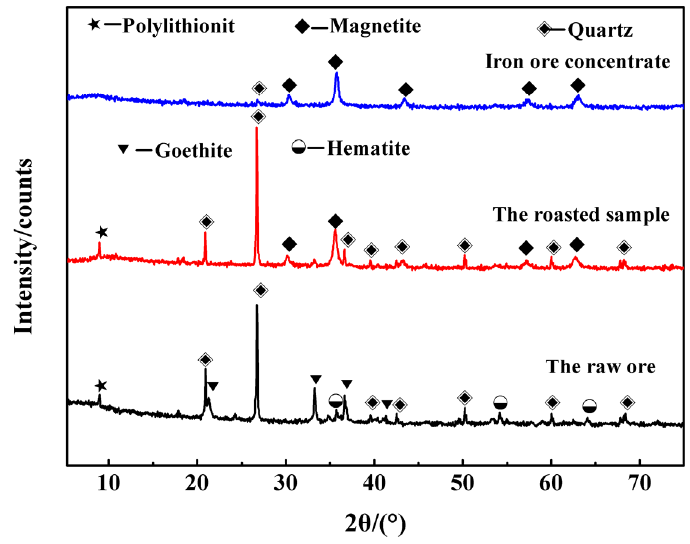
Figure 5. XRD pattern analysis of raw ore, roasted sample, and iron ore concentrate.